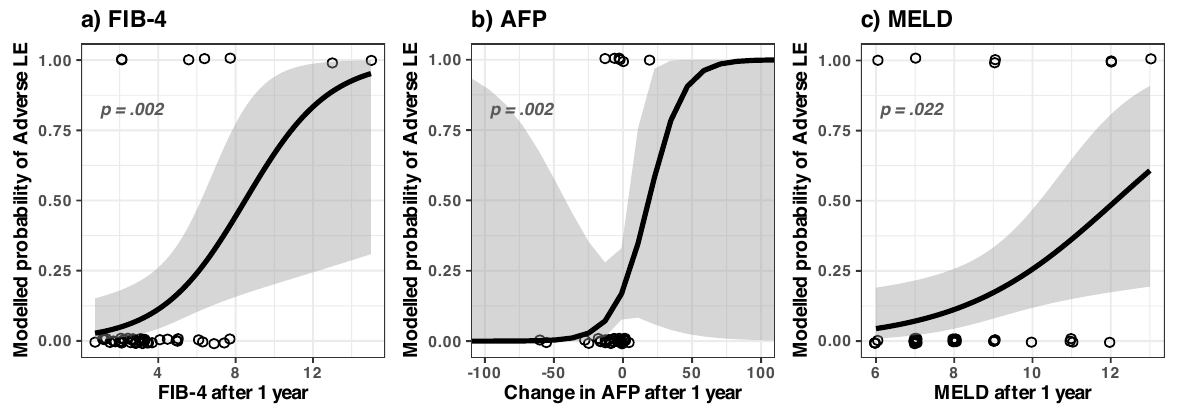
Figure 4. Modelled odds ratio (OR) of adverse liver events vs. nonevents as a function of FIB-4, AFP change and MELD scores. The grey bands represent the 95% confidence interval; only the statistical significant ( p < 0.05) predictors are displayed; see Table A3 for the full numerical model.